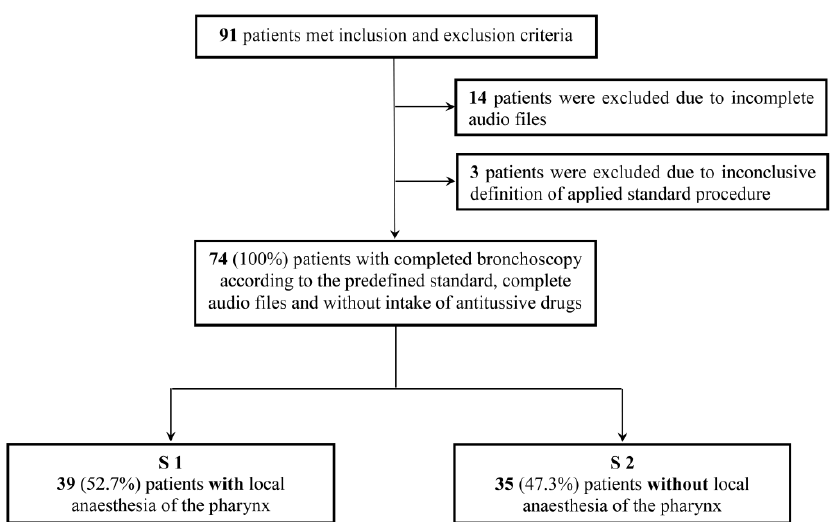
Figure A2. Study population. S1—Standard 1 with LAP, S2—Standard 2 without LAP.